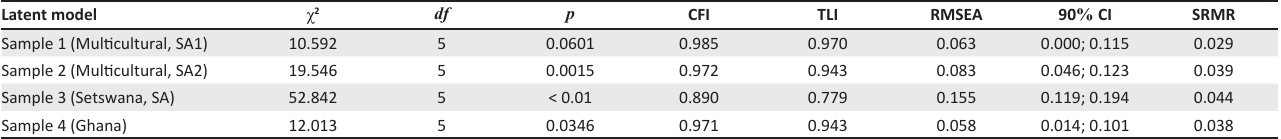
TABLE 3: Standardised factor loadings, residual variances, R 2 -values and omega coefficients of the Harmony in Life Scale for the various samples. Item